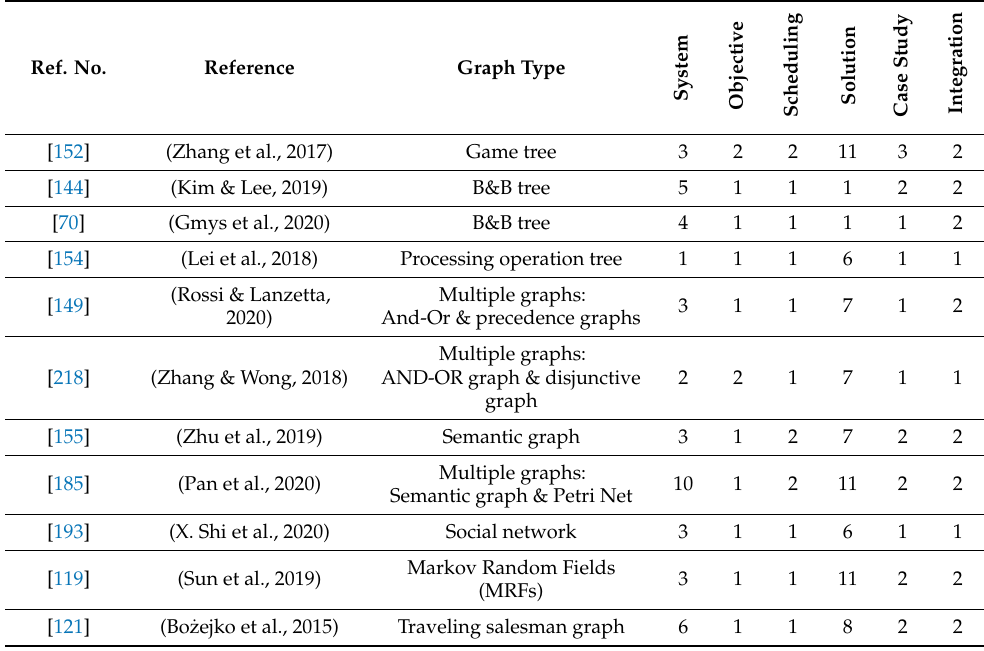
Figure 30. Modeling and coding different properties of shop scheduling problems using micro- categories proposed in this paper. Table 9. Samples of gaps in the literature: The properties of problems using the least common graph types in our